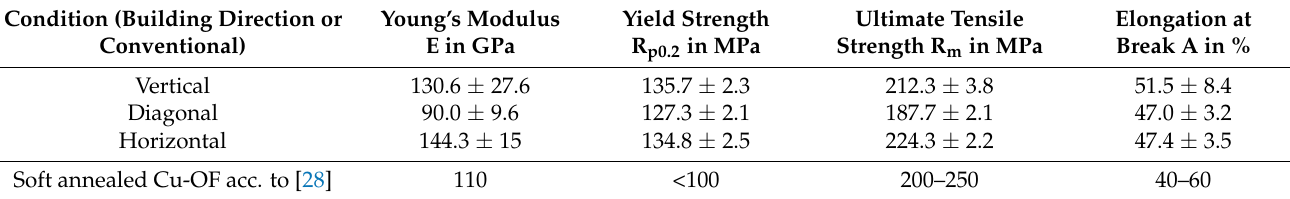
Table 6. Tensile testing results of